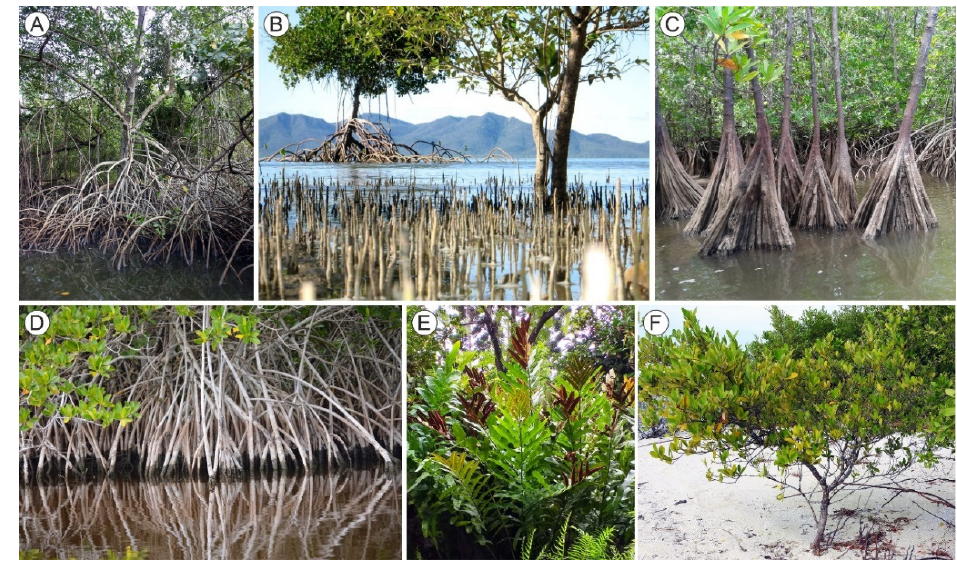
Figure 2. Examples of mangrove-forming trees from the Caribbean region. ( A ) Rhizophora mangle ; ( B ) Avicennia germinans ; ( C ) Pelliciera rhizophorae ; ( D ) Laguncularia racemosa ; ( E ) Acrostichum aureum ; ( F ) Conocarpus erectus . Modified from Ref. [20].